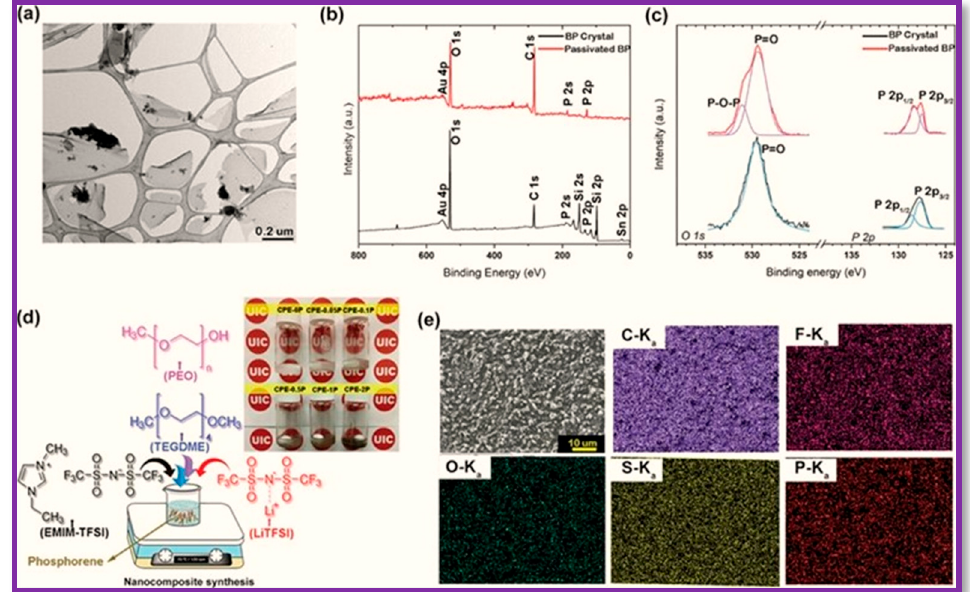
Figure 13. Preparation of the nanocomposite polymer electrolyte with passivated BP nanosheets additive. ( a ) TEM micrograph of the BP nanosheets, ( b ) survey XPS spectra, and ( c ) high-resolution XPS spectra of the P 2p and O 1 s signals of the pristine BP crystal and passivated BP nanosheets. ( d ) Overall synthesis procedure. Inset: photograph of the developed electrolytes. From left to right: CPE-0P (no additive) and nanocomposite polymer electrolytes with 0.05, 0.1, 0.5, 1, and 2 wt% of passivated BP nanosheets. ( e ) SEM image of the 0.5 wt% with the corresponding EDS mapping.